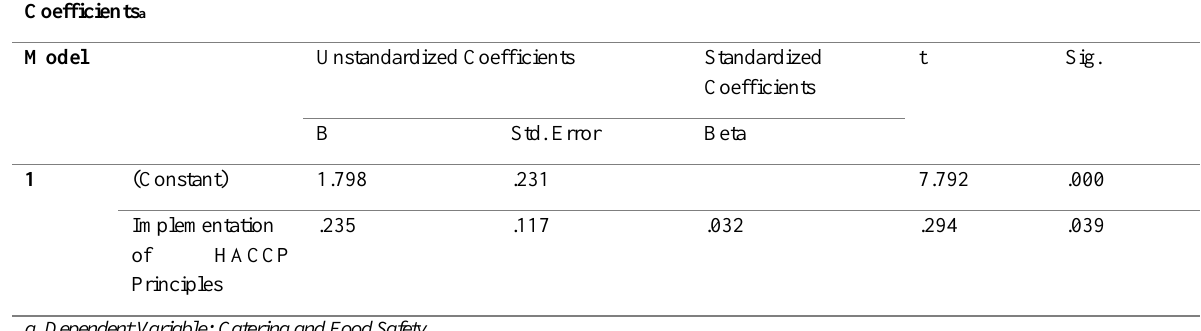
Table 3: Regression Coefficient of Implementation of HACCP principles on Catering and Food Safety